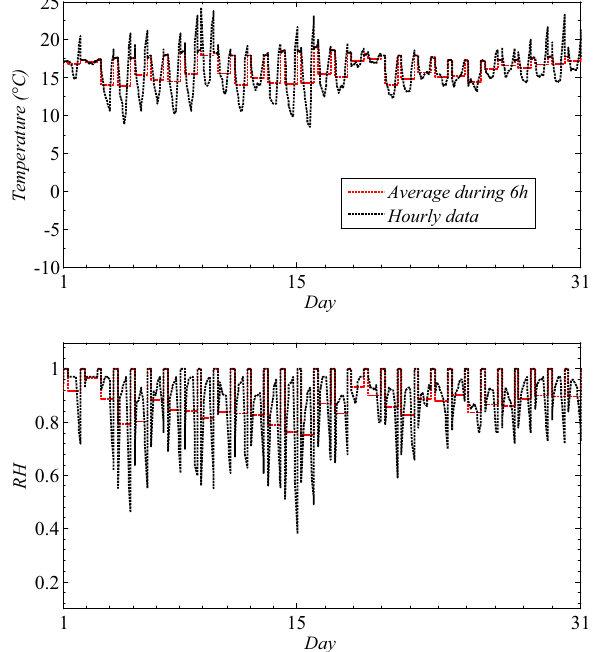
Fig. 7 Environmental and imposed boundary conditions for a month, in Brest, France.